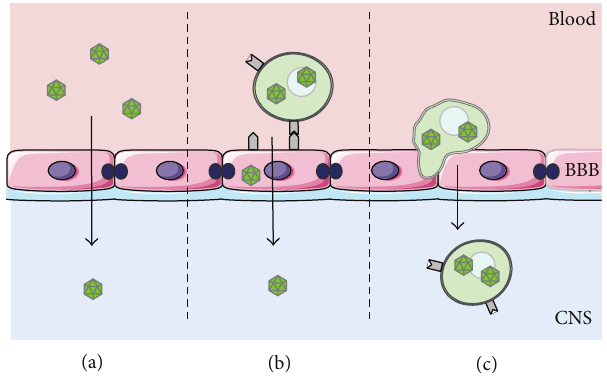
Figure 3: Mechanisms of PML pathogenesis. The necessary condi- tion for the PML developments is that oligodendrocytes are infected by JCV. In this figure the three ways through which the virus could cross the BBB are represented: (a) as free virus or (b) the infection of the endothelial cells of the barrier by JCV-infected B cells (c) using the B cells as “a Trojan